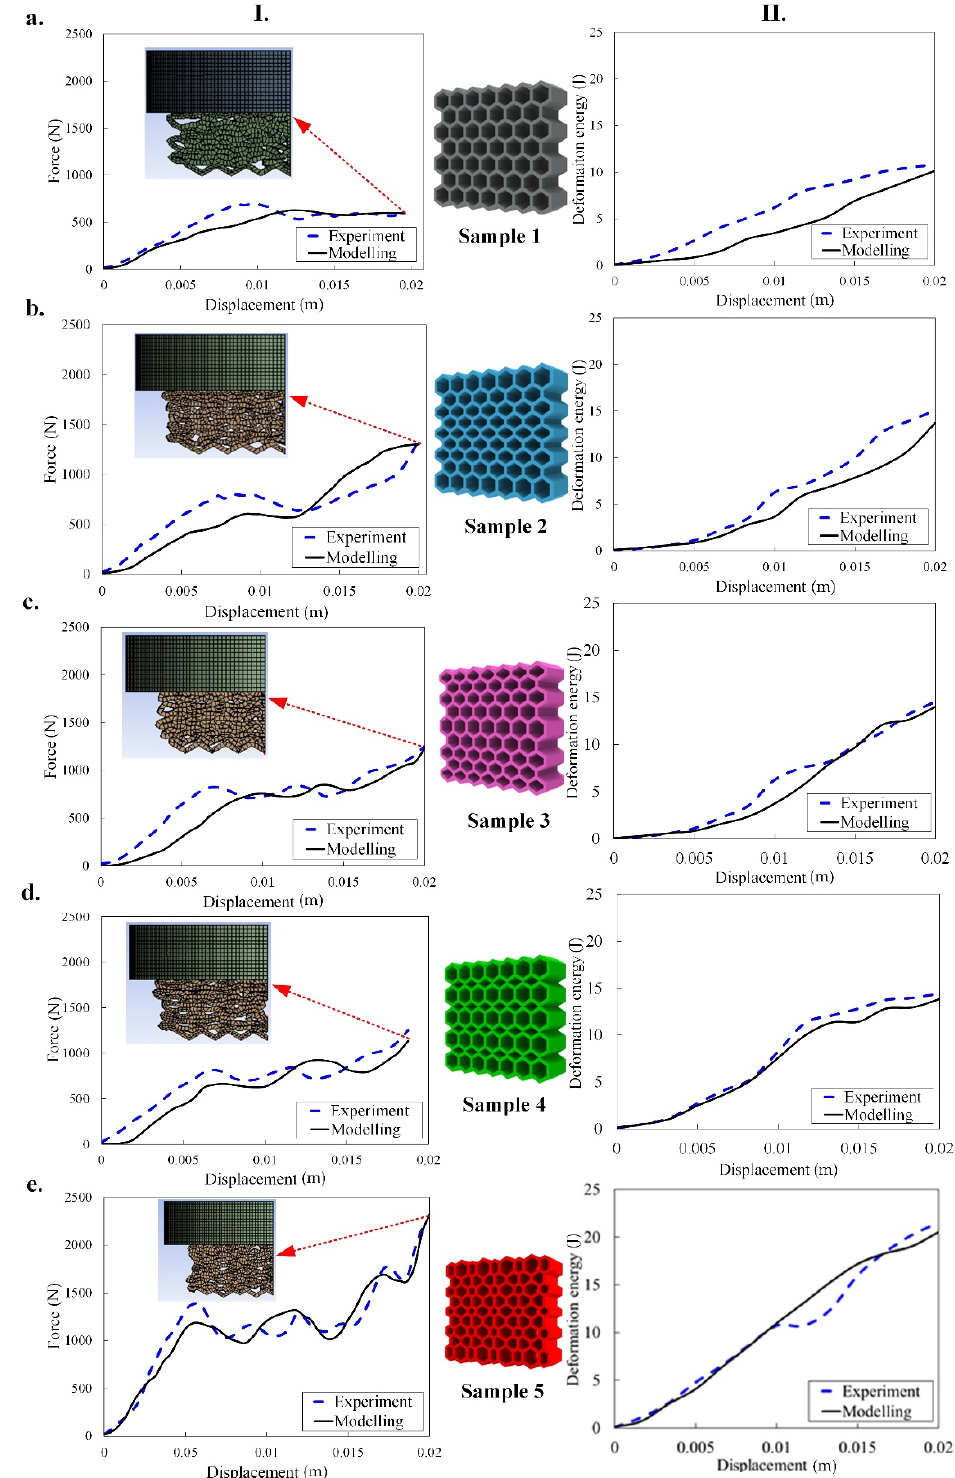
Figure 5. Experimental and numerical uniaxial force-displacement response (I) and deformation energy absorption (II) of the five samples ( a – e ) made of TPC under a quasi-static compression test.